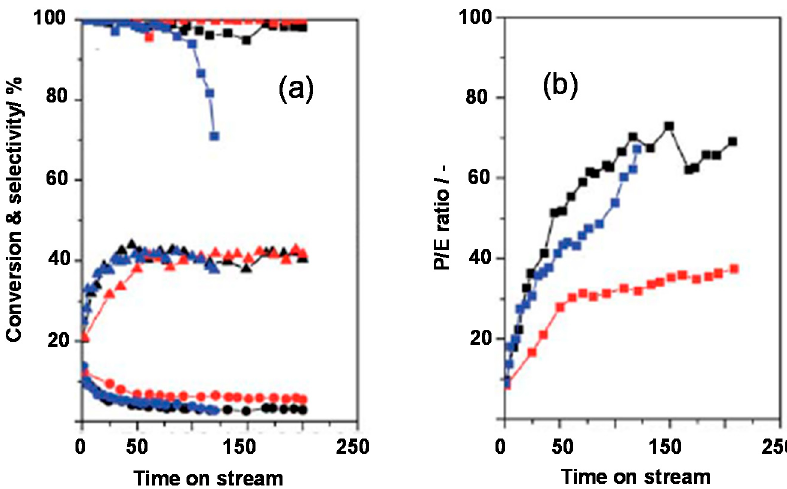
Figure 13. The catalytic performance of pristine HZSM-5 (red color), the mechanical mixture HZSM-5@S15 (blue color) and HZ@15 composite (black color): ( a ) methanol conversion (square), selectivity of ethylene (circle) and propylene (triangle); ( b ) the propylene to ethylene (P/E) ratio. Adapted with permission from [43]. Copyright Royal Society of Chemistry, 2011.